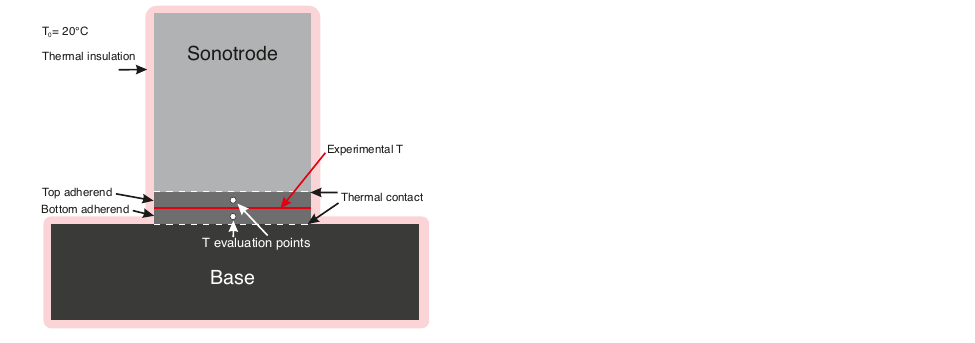
Figure 5. Schematic model with boundary conditions for heat transfer model of static welding setup. Table 2. Material Properties used for